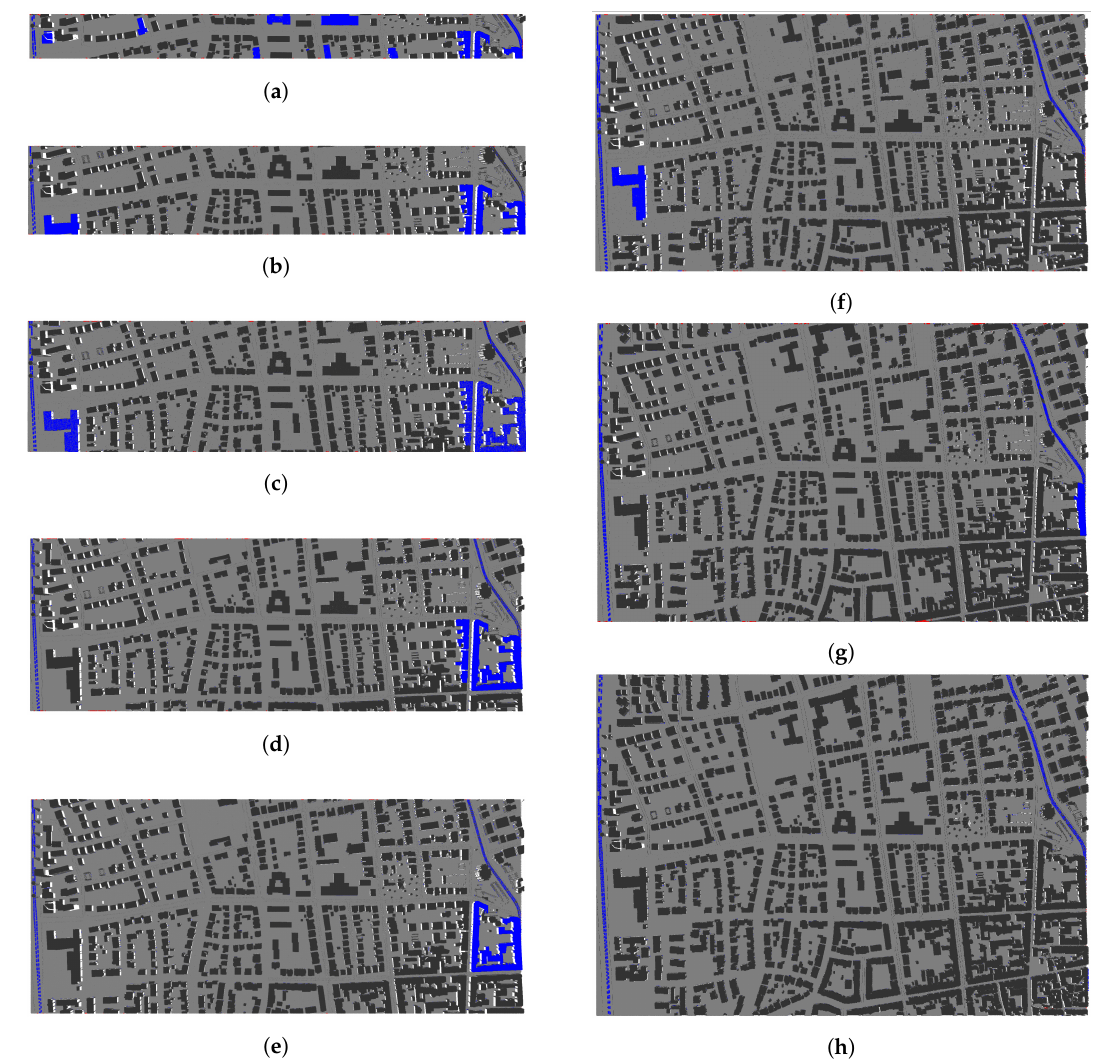
Figure 18. Error distribution in the synthetic Heidelberg’s urban site for different scan-line